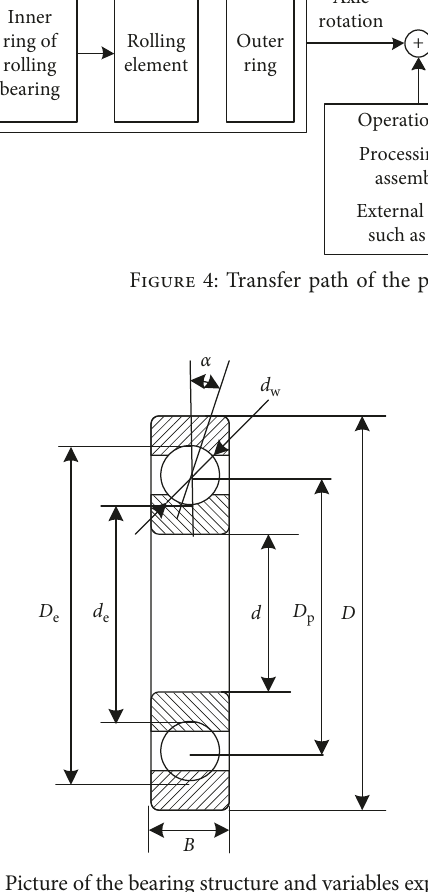
Figure 5: Picture of the bearing structure and variables explanation. Table 1: Parameters of the test bearing. Parameters Size Inner diameter of bearing d Outside diameter of